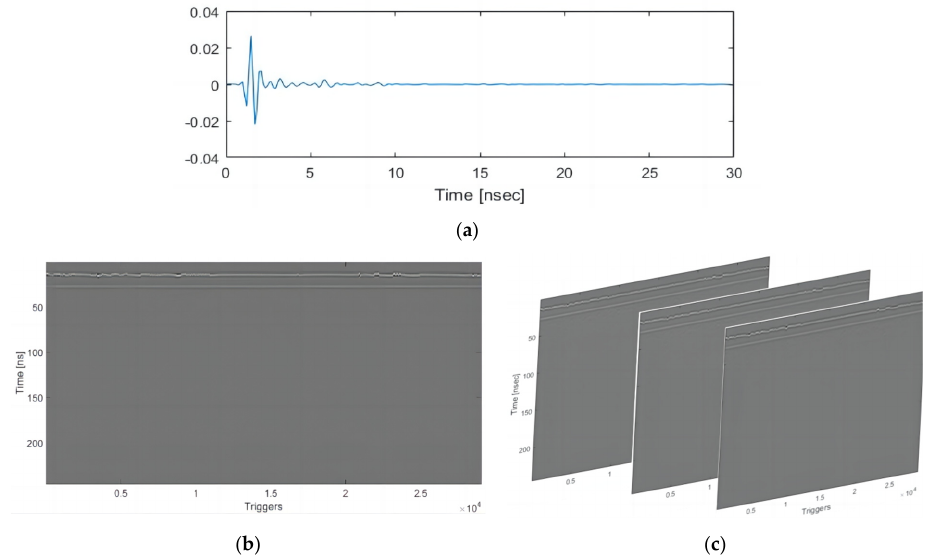
Figure 2. Ground − penetrating radar data in di ff erent dimensions. ( a ) A − Scan. ( b ) B − Scan. ( c ) C- Figure 2. Ground–penetrating radar data in different dimensions. ( a ) A-Scan. ( b ) B-Scan. ( c ) Scan . When the antenna moves forward, the distance of the device is recorded through the distance encoder (DMI), and the antenna is triggered equally to collect data, forming two dimensions in the driving direction and the depth direction, namely, the B-Scan, as shown in Figure 2b. The 3D GPR antenna has 20 pairs of antennas, which can collect 20 B-Scans at the same time. The combination of multiple horizontal slices can form 3D data with the driv- ing direction, the transverse direction, and the depth direction, namely, the C-Scan, as shown in Figure 2c. In the process of the C-scan data analysis, the sections can be cut from three direc- tions: as shown in Figure 3, in the horizontal section (XY Plane, green), the longitudinal section (XZ Plane, purple), and the transverse section (YZ Plane, red) to analyze the data. During the process of the radar data recognition, the 3D radar data (C-Scan) were trans- formed into 2D image data (B-Scan) in a form of slices to ease recognition. The 3D coordi- nate system was established with the traveling direction of the radar antenna in the X - axis, the depth direction perpendicular to the ground in the Z -axis, and the direction per- pendicular to the X–Z plane in the Y -axis. Figure 3. Three slicing methods for 3D ground-penetrating radar data.